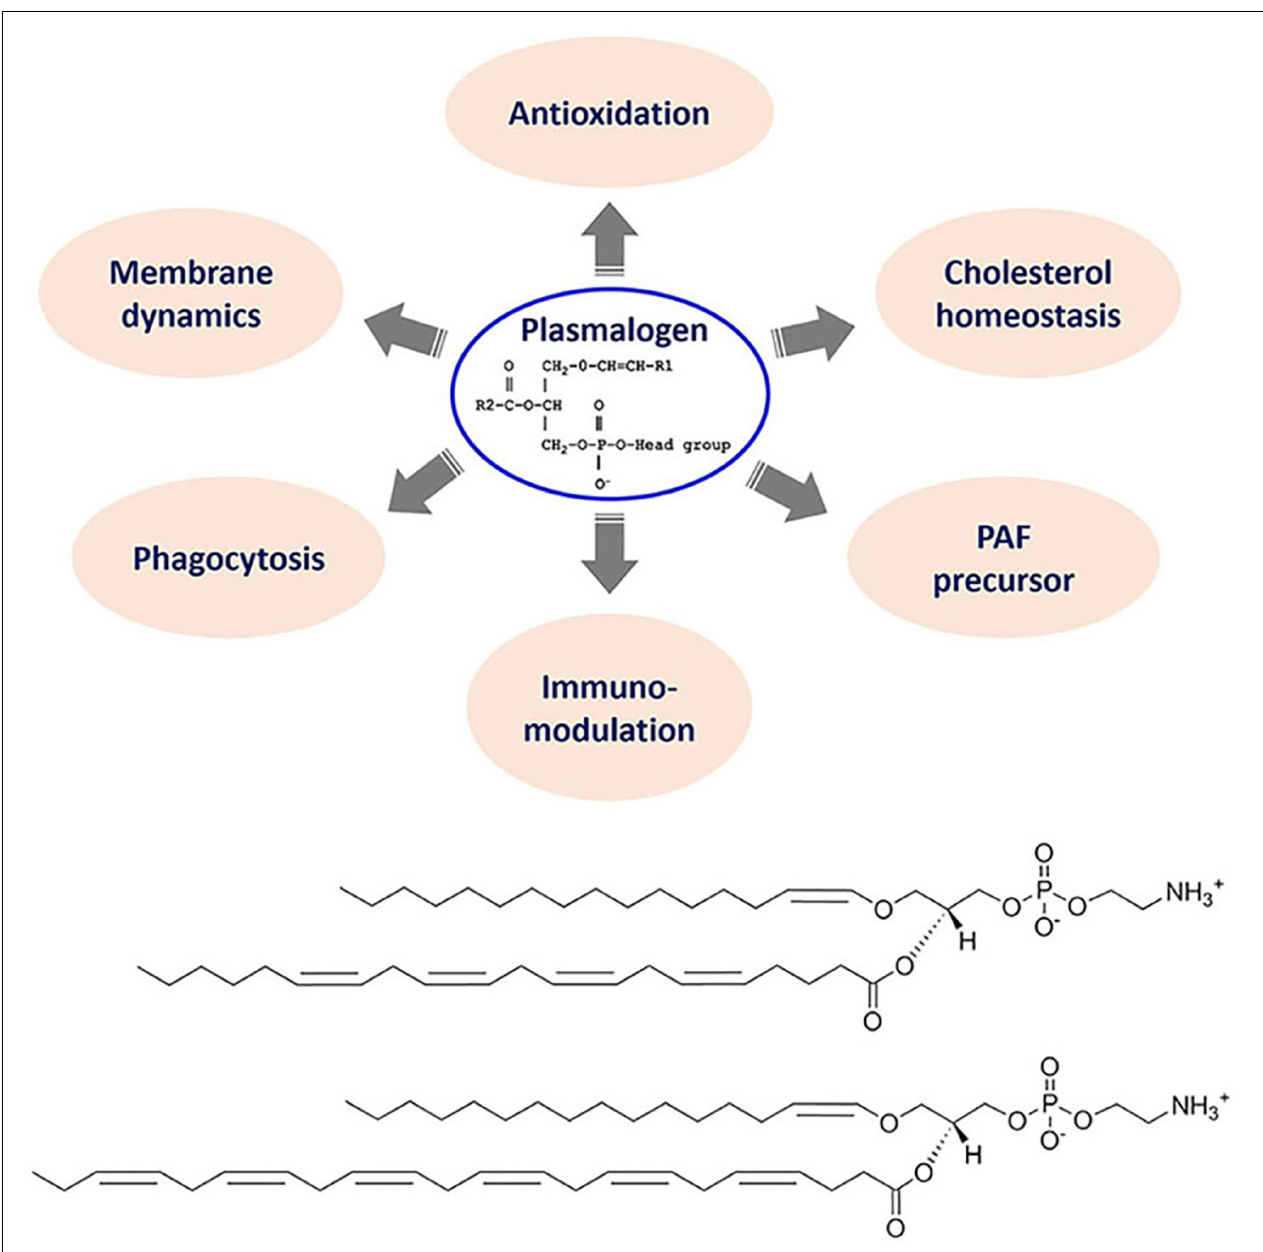
FIGURE 4 | Top panel: General chemical structure and multiple biological functions of bioactive plasmalogens. Bottom panel: Chemical structures of exemplary ether phospholipids (plasmalogens) involving arachidonic acid (AA) and docosahexaenoic acid (DHA) chains, e.g., 1-(1Z-hexadecenyl)-2-arachidonoyl-sn-glycero-3- phosphoethanolamine [C16(Plasm)-20:4 PE] and 1-(1Z-hexadecenyl)-2-docosahexaenoyl-sn-glycero-3-phosphoethanolamine [C16(Plasm)-22:6